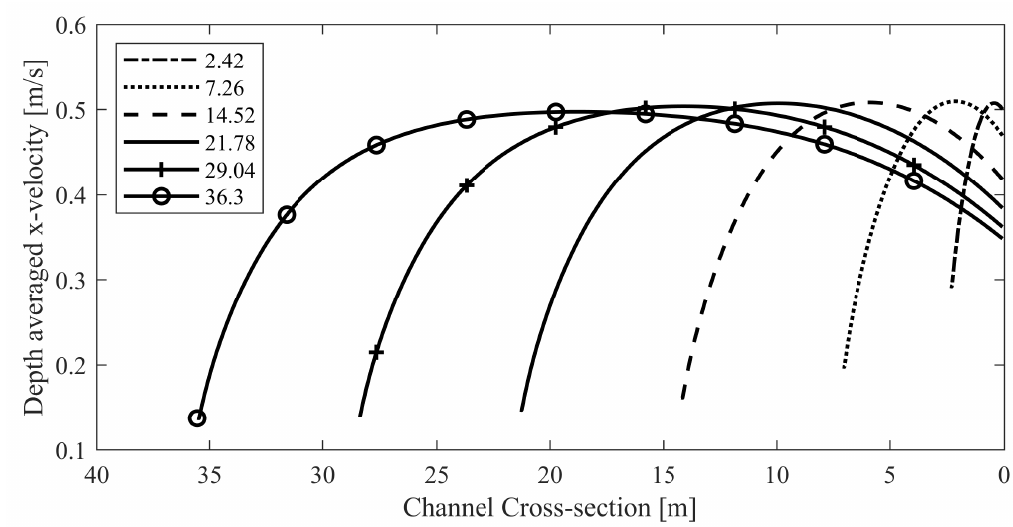
Figure 8. Depth averaged x-velocity on a crosssection through different variations of the NFM with a width indicated by the legend in